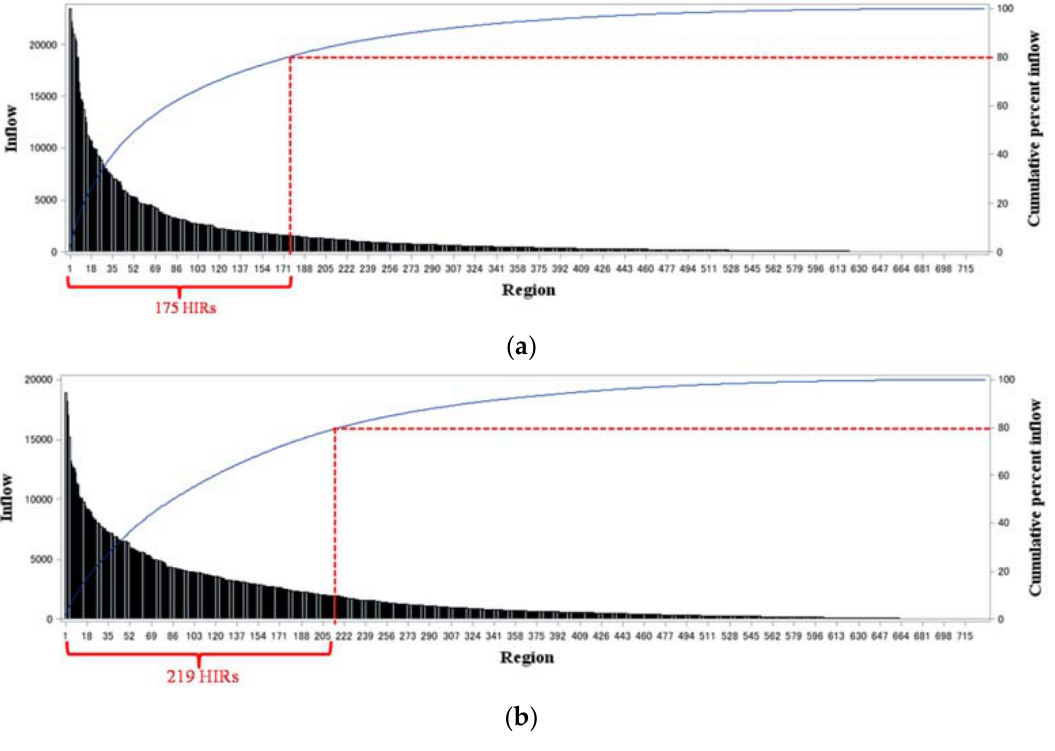
Figure 3. Distribution of inflows and selection of HIRs. ( a ) 175 HIRs selected from morning peak hour data; ( b ) 219 HIRs selected from evening peak commute data.